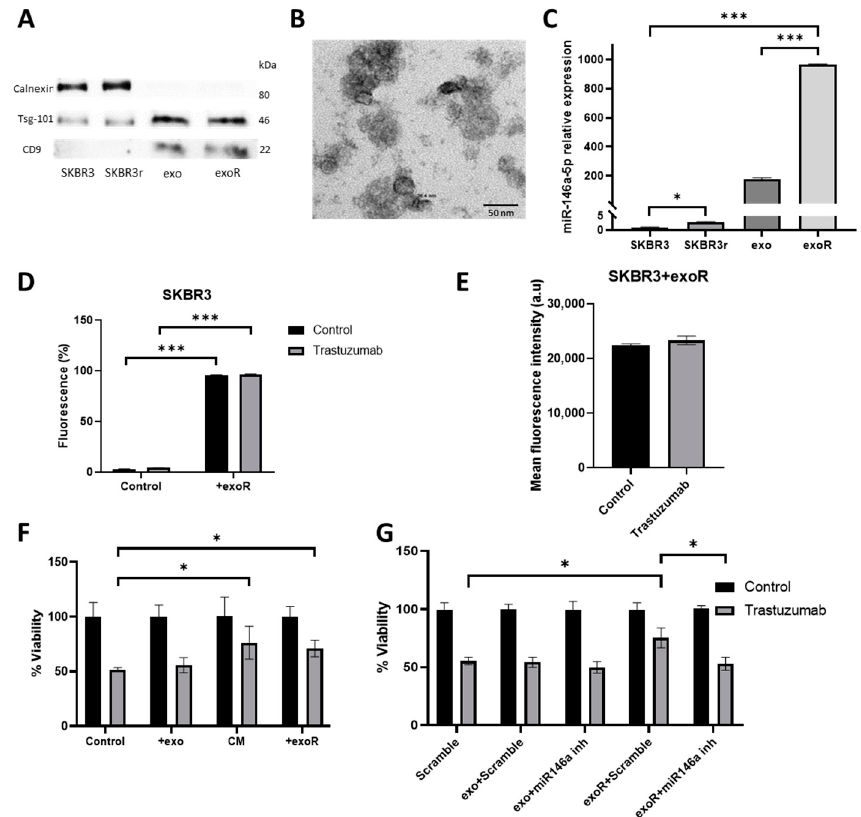
Figure 5. Characterization of SKBR3 exosomes and their effect in trastuzumab response. ( A ) Western blot was performed for measuring the presence of TSG-101 and CD9 typical from exosomes, and the absence of calnexin as a cellular control. ( B ) Representative image of exosomes observed via TEM (microscope JEOL1010, 60,000 × Magnification) (scale bar: 50 nm). ( C ) Analysis via RT-qPCR of miR-146a-5p expression in exosomes from SKBR3 (exo), exosomes from SKBR3r (exoR) line, and from SKBR3 and SKBR3r cell lines. miR-16a was used as endogenous miRNA. ( D ) Percentage of fluorescent cells detected via flow cytometry after exosome internalization assay with DMEM F-12 alone or exoR containing ( E ), and mean of fluorescence detected in cells treated or not with trastuzumab. ( F ) Viability assay of the SKBR3 cell line co-cultured with 50% of CM from SKBR3r or exoR, treated with or without 15 µg/mL trastuzumab for 7 days. ( G ) Viability assay of the SKBR3 cell line co-cultured with exoR after transfection with miR-146a-5p inhibitor with or without 15 µg/mL trastuzumab for 7 days. Each experiment was performed in technical and biological triplicate. * p -value < 0.05; *** p -value < 0.001. The uncropped blots are shown in Figure S5.